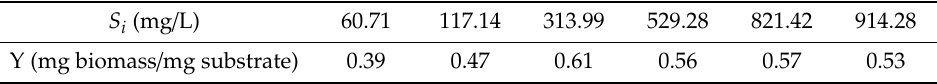
Table 3. Cell mass yield at di ff erent initial